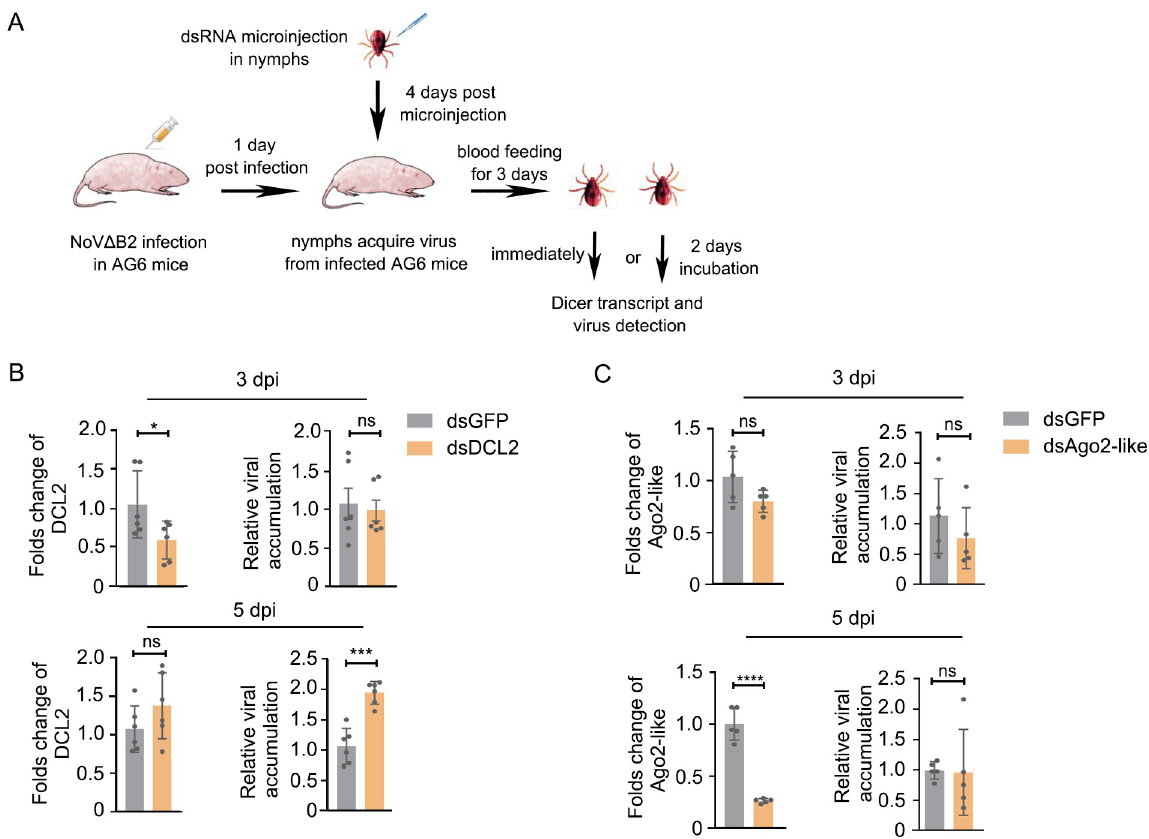
Fig 5. Putative Dicer2-like protein restricts viral infection in H . longicornis . (A) Schematic overview of dsRNA treatment in ticks. Briefly, AG6 mice were infected with NoV Δ B2 by intraperitoneal injection. Nymphs injected with dsRNAs were allowed to parasitize AG6 mice for 3 days (designed as 3 dpi). After removing from the mice, half of nymphs was incubated for an additional 2 days (designed as 5 dpi). The HlDCL-2 and HLAgo2-like transcript levels and relative virus accumulations were determined by RT-qPCR. (B and C) Folds change of HlDCL-2(B) and HLAgo2-like(C) transcript level and viral accumulations in ticks with NoV Δ B2 infection relative to dsGFP control. dsGFP: dsRNA targeting GFP, dsDCL2: dsRNA targeting HlDCL-2, dsAgo2-like: dsRNA targeting HlAgo2-like. For RT-qPCR analyses, ΔΔ Ct method was used, the data represents mean ± SEM values of 5~6 biological replicates (3~5 nymphs per biological replicate). Significance was determined by the Mann- Whitney test. ns: not significant, � P < 0.05, ��� P < 0.001, ���� P < 0.0001. Each experiment was repeated at least three times independently with one represented image